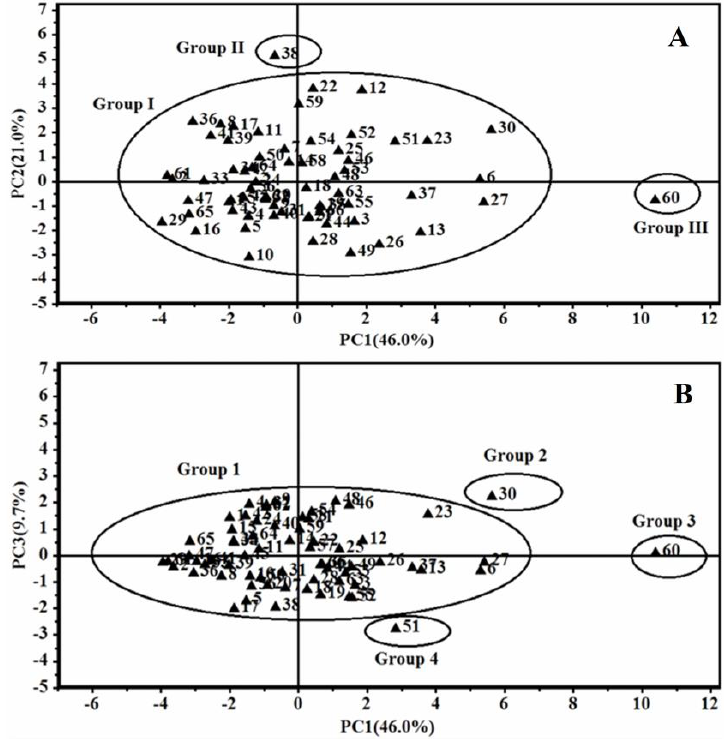
Figure 4. Scores plot of PCA for 66 samples of GRR. The scores plots for PC1 versus PC2 ( A ) and PC1 versus PC3 ( B ).